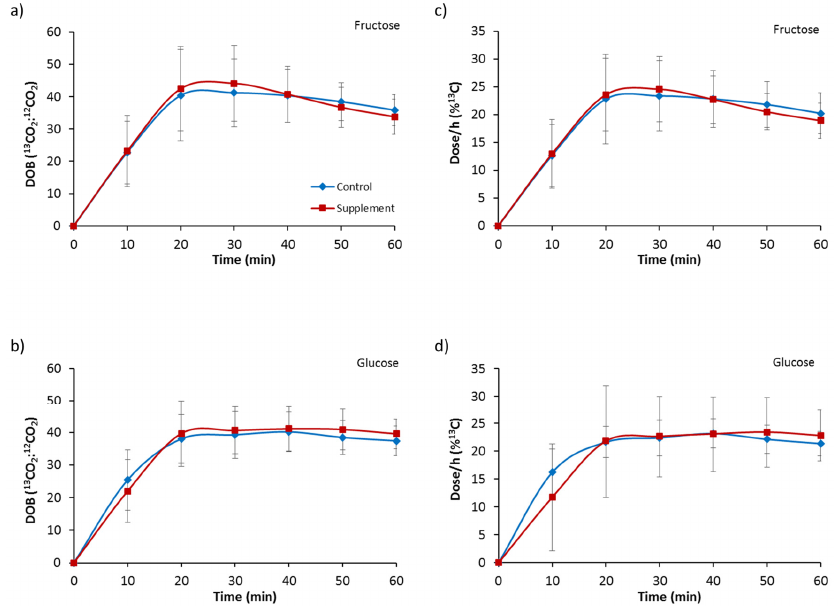
Figure 1. Gastric emptying delta over baseline (DOB) for 60 min following ingestion of ( a ) a 6% fructose solution and ( b ) a 6% glucose solution, and dose/h (% 13 C) following ingestion of ( c ) a 6% fructose solution and ( d ) a 6% glucose solution. Treatments were control without fructose supplementation and with three days of supplementation with 120 g fructose per day. Values are mean ± standard deviation.